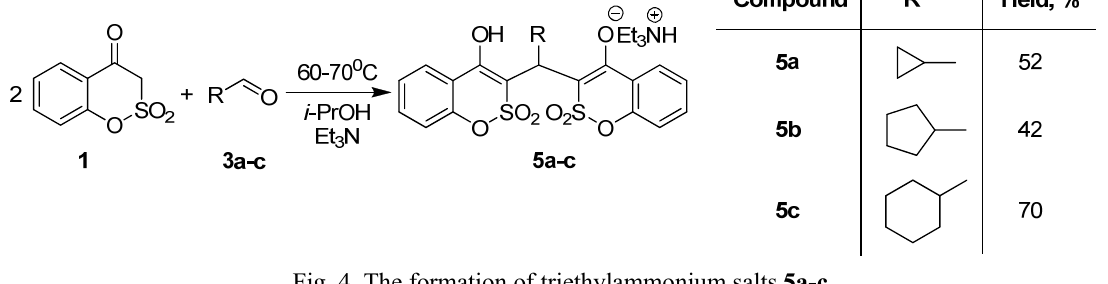
Fig. 4. The formation of triethylammonium salts 5a-c